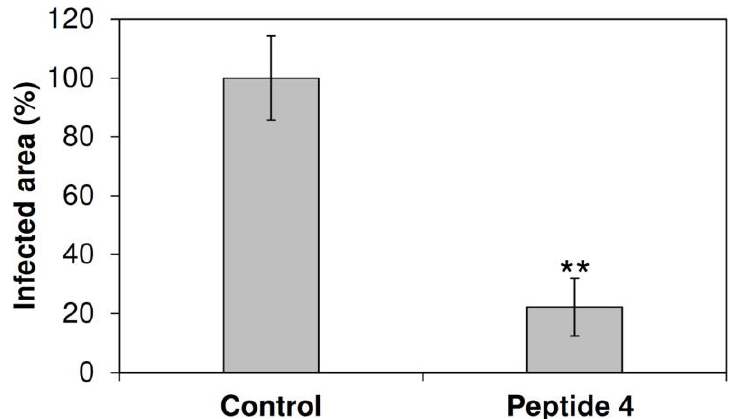
Figure 5. Symptomatic area of grapevine leaves cv. Glera treated with 4 at 50 µM and inoculated with B. cinerea conidia. The symptomatic leaf area was measured 7 days post-inoculation (dpi) and is expressed as a percentage compared to the control (treated with water). Bars indicate standard error. Three independent infection experiments were performed. Data were statistically analyzed by the Student’s t -test. Each treatment was compared to the respective control. ** indicates significant differences at p < 0.01. Table 3. Protection of grape berries from B. cinerea infection by treatment with 4 at 50 µM.